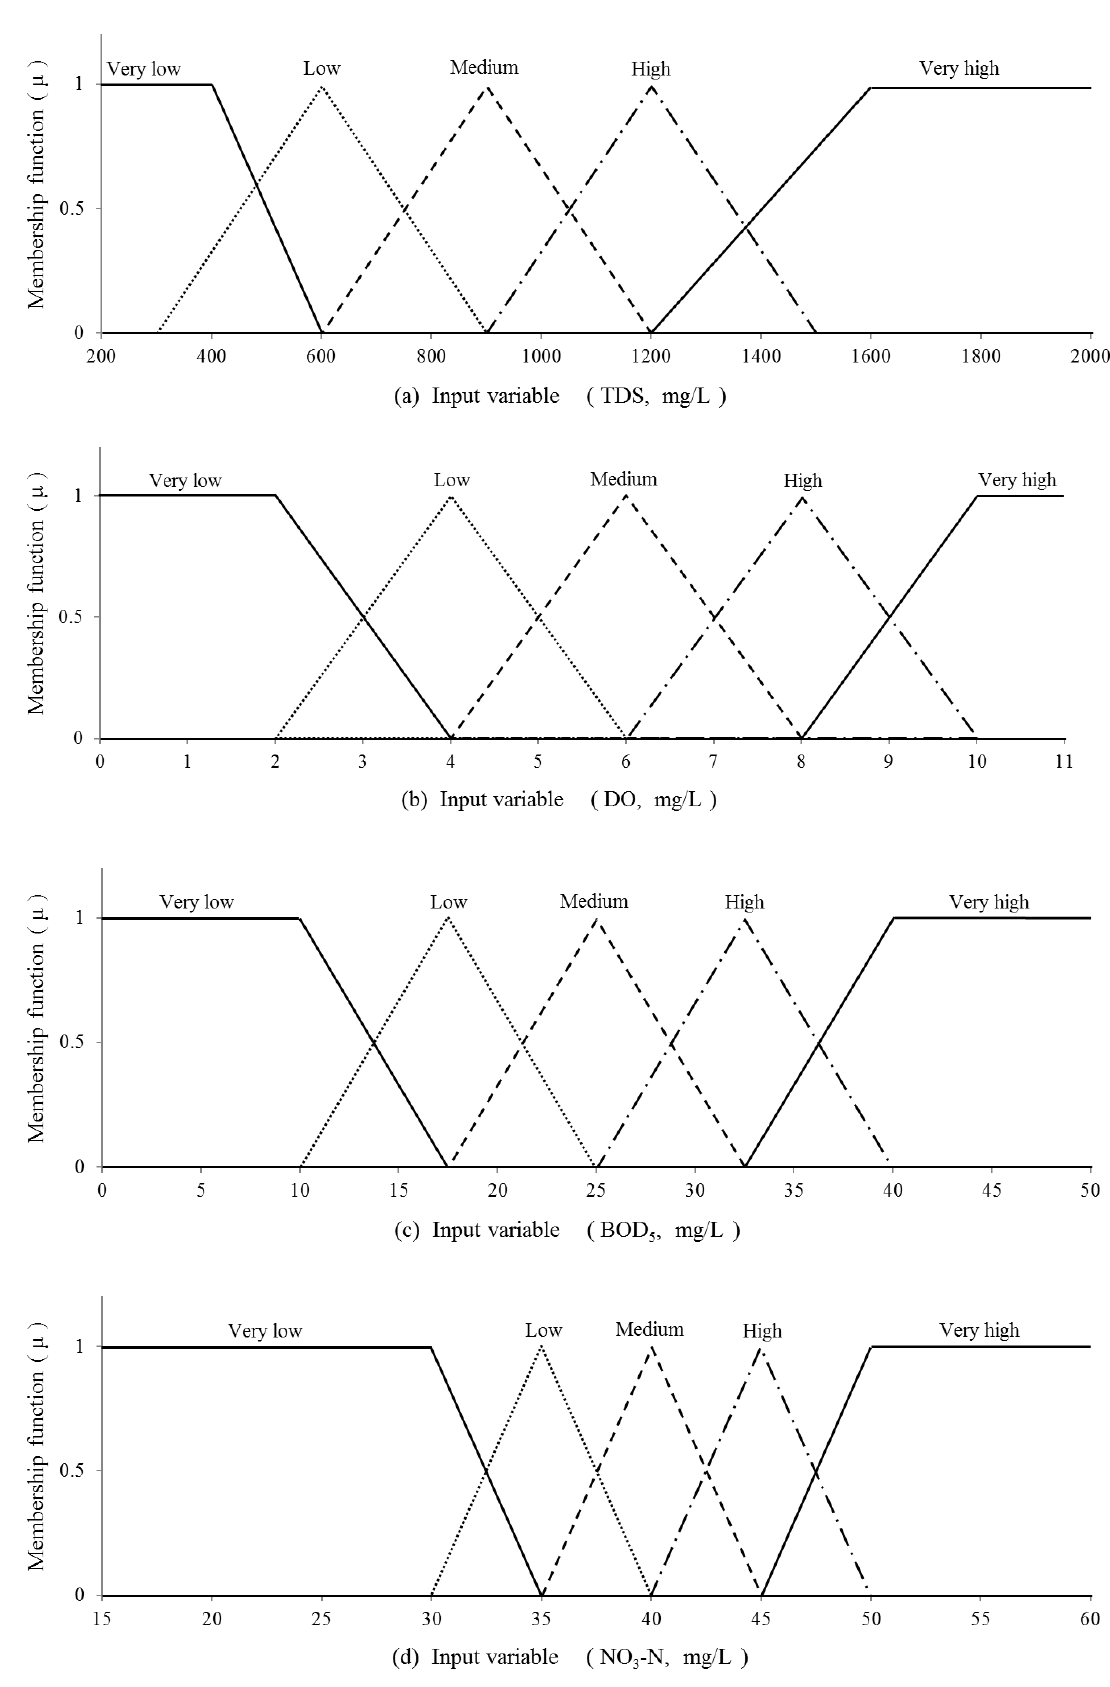
Figure 2. The fuzzy set membership functions of the input variables: ( a ) TDS; ( b ) DO; ( c ) BOD 5 and ( d ) NO 3 -N.